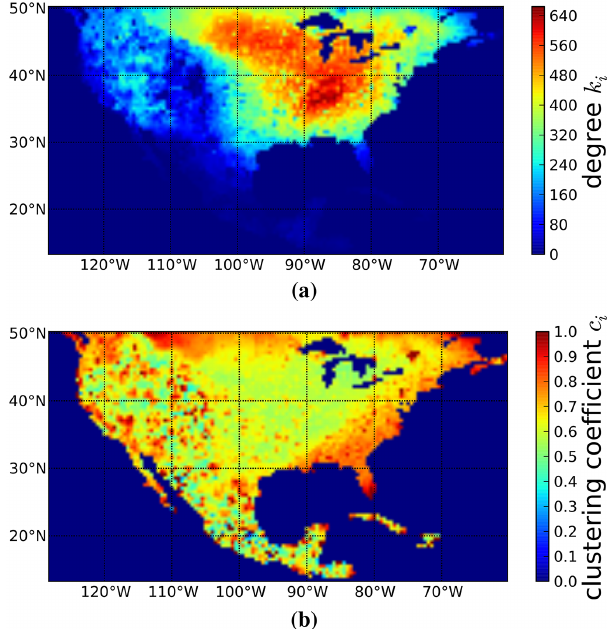
Figure 2. (a) Degree k i and (b) clustering coefficient c i obtained from the network of temperature correlations.